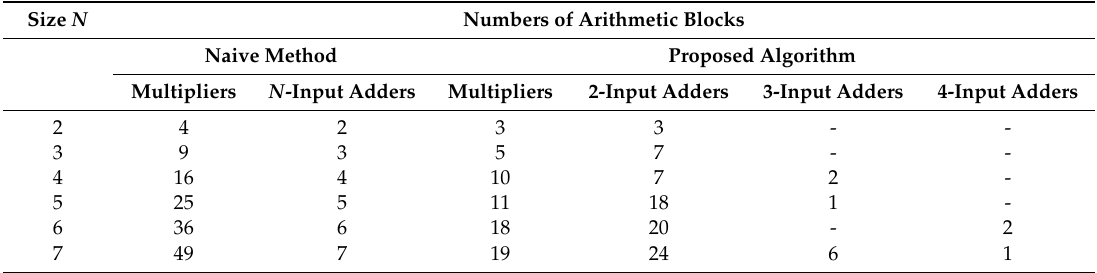
Table 1. Implementation complexities of naive and proposed